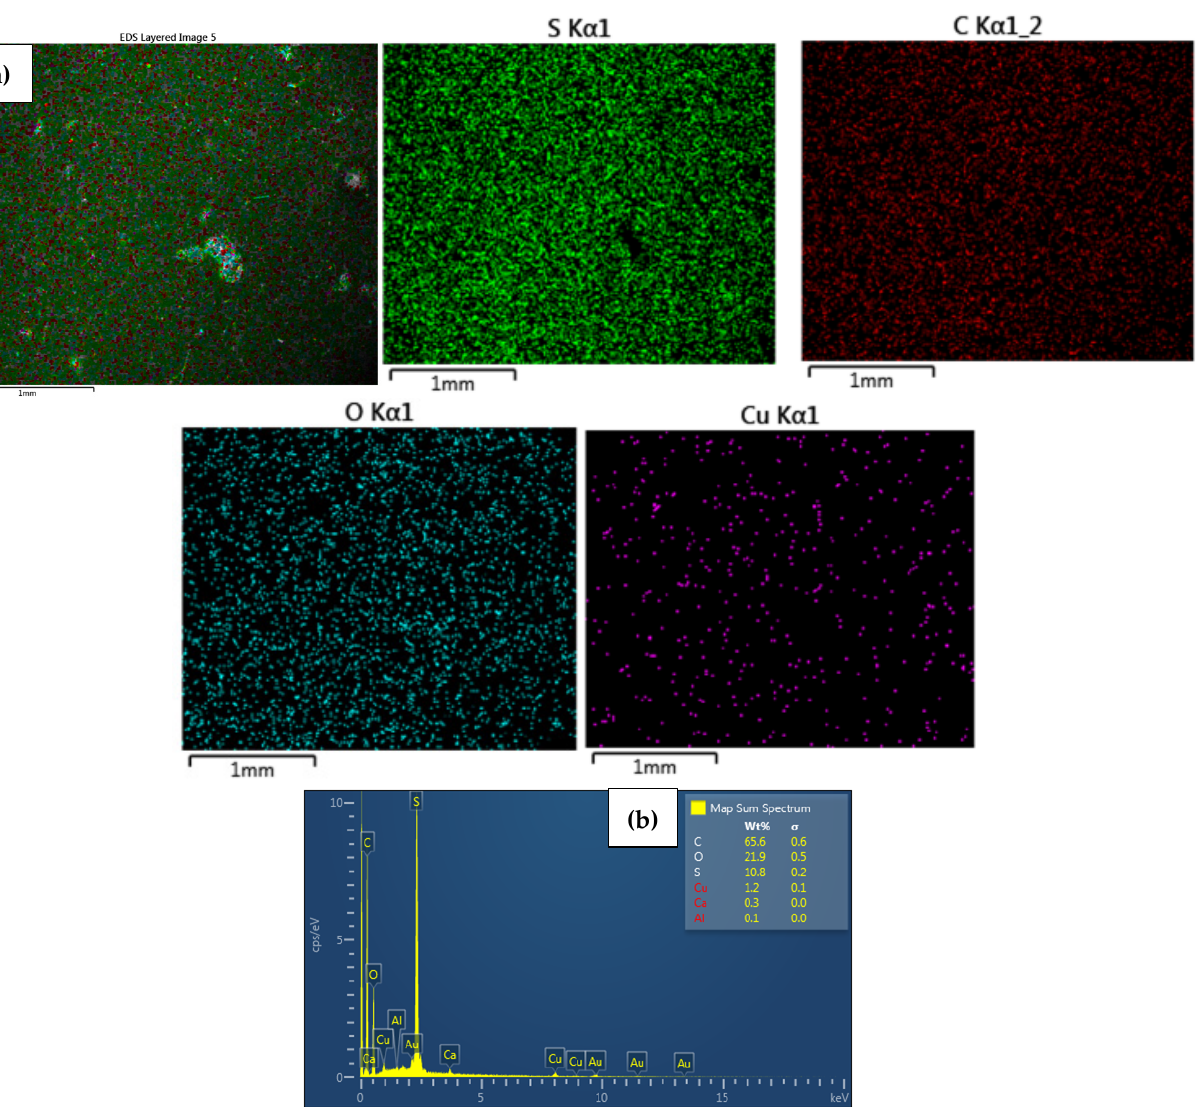
Figure 4. Elemental maps showing the composition of the analyzed CEM membrane surface; ( a ) combined elemental mapping of C, S, O and Cu and ( b ) EDS spectra confirming the presence of AgNPs of CuNPs of CEM-Cu3 nanocomposite membrane.